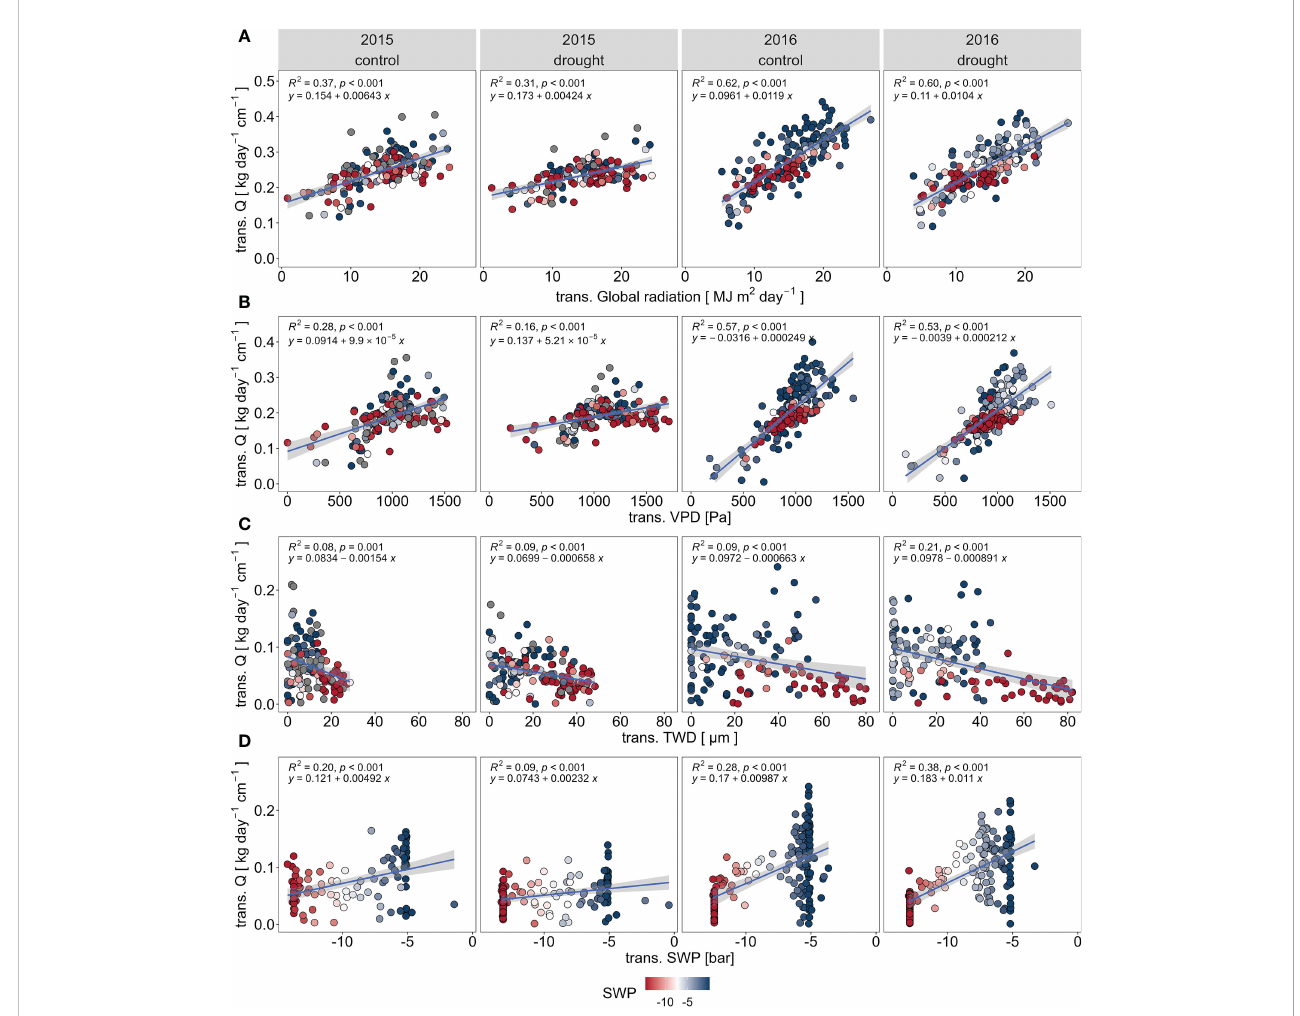
FIGURE 5 Responses of transformed speci fi c sap fl ow Q to microclimatic conditions and transformed tree water de fi cit TWD in control (PC) and drought (PE) plots in 2015 and 2016: transformed global radiation GR (A) , transformed vapor pressure de fi cit (VPD) (B) , transformed tree water de fi cit TWD (C) , and transformed mean soil water potential SWP (D) . The values are derived from the Cochrane-Orcutt